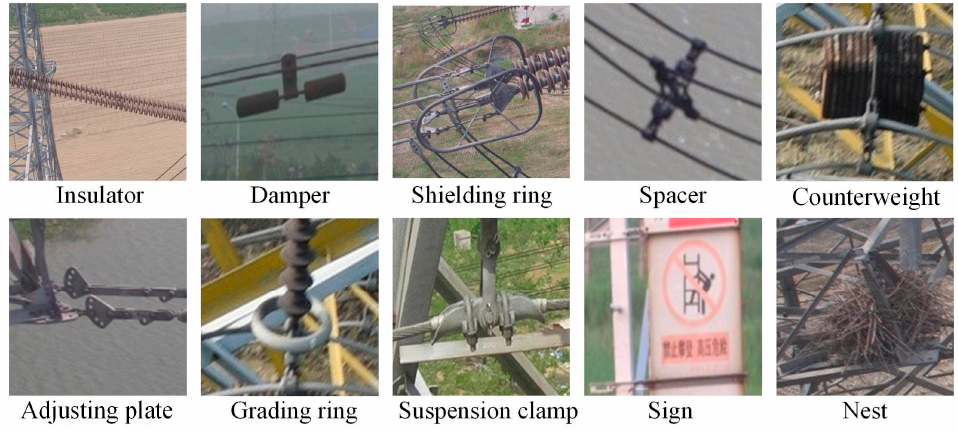
Figure 10. Objects to be